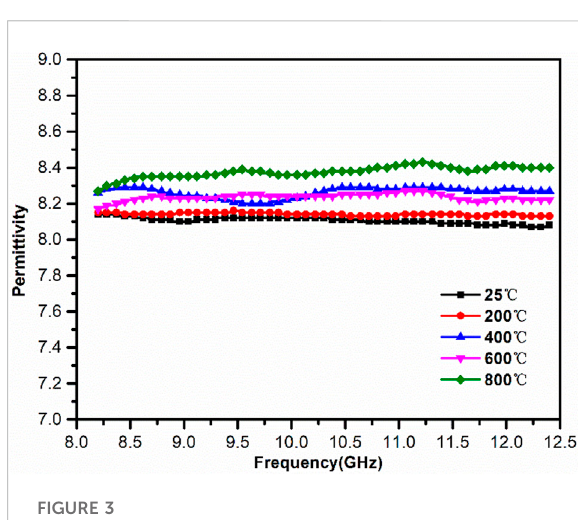
FIGURE 3 Permittivity of the Al 2 O 3 ceramic with frequency at different